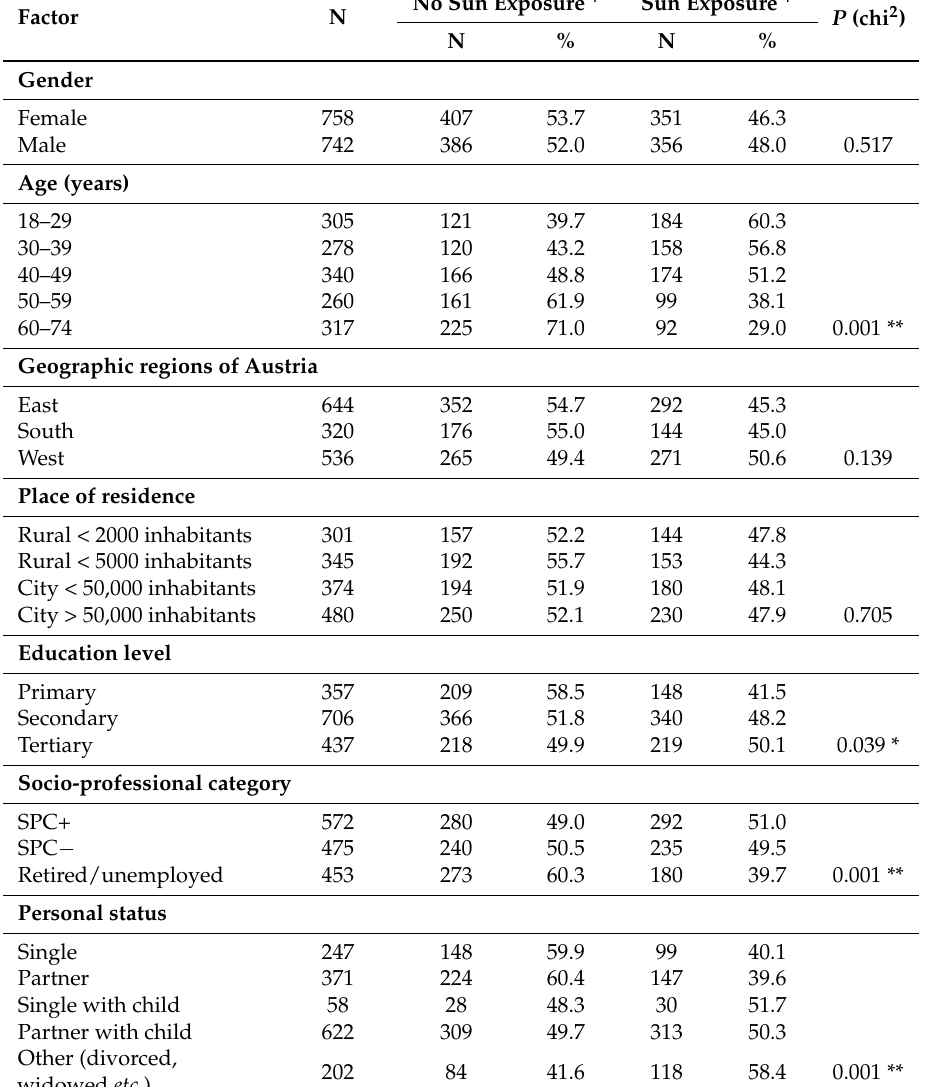
Table 2. Socio-demographic characteristics of the study population, stratified by sun exposure prevalence